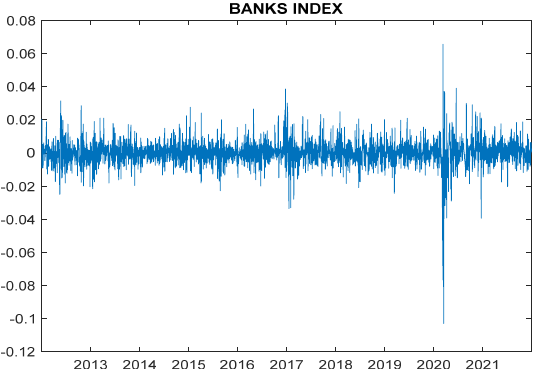
Figure 2. Evolution of bank share prices before and during the COVID-19 crisis.